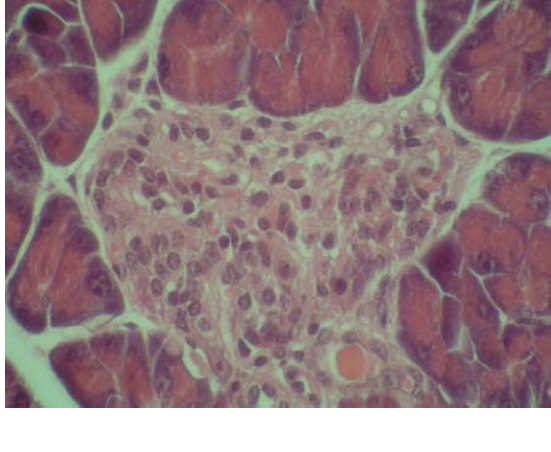
Figure 5. Microphotograph of pancreas – the effect of diplacone ( 1 ) on the pancreatic histopathology of diabetic mice (HE 600×). Pancreatic islet with an irregular shape; with vacuolised cytoplasm, a pyknotic nucleus and tiny necrosis without a significant inflammatory